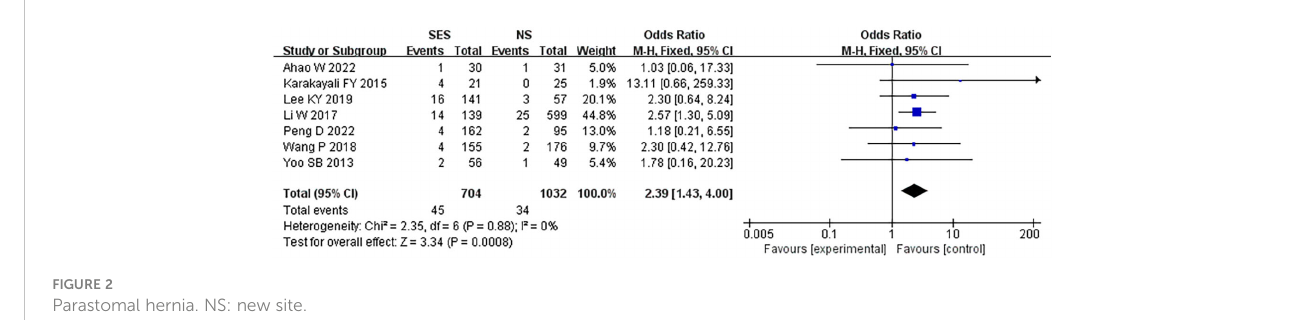
FIGURE 2 Parastomal hernia. NS: new site.